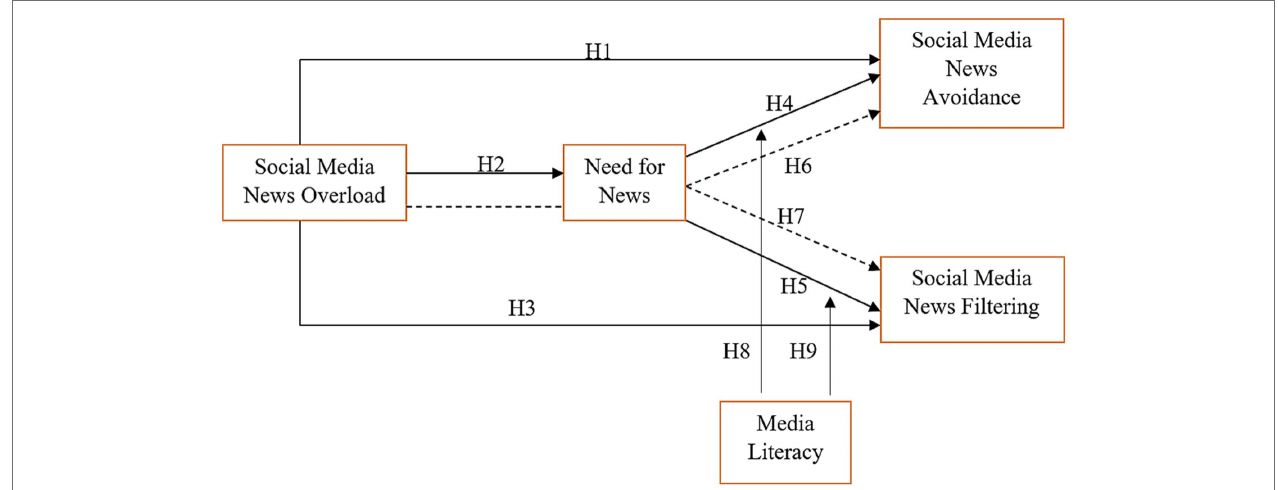
FIGURE 1 | Theoretical